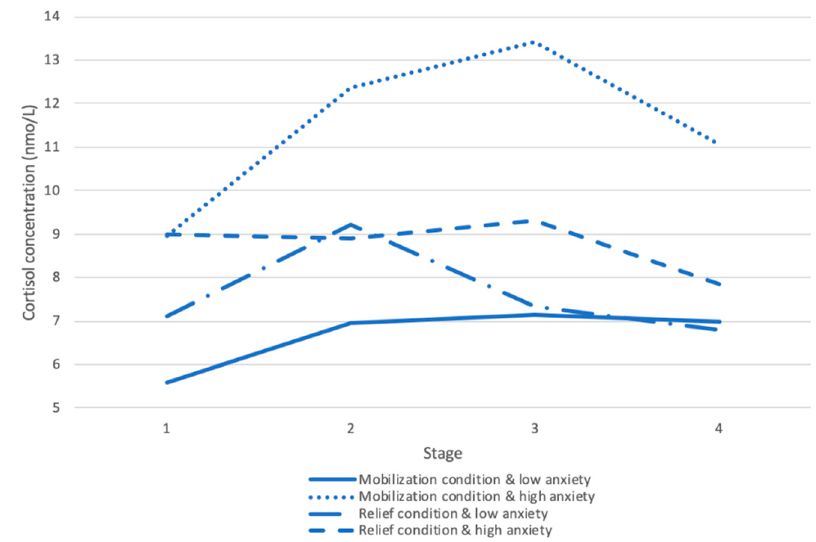
Figure 4. Changes in salivary cortisol concentrations throughout the four stages among people high and low on attachment anxiety. and low on attachment